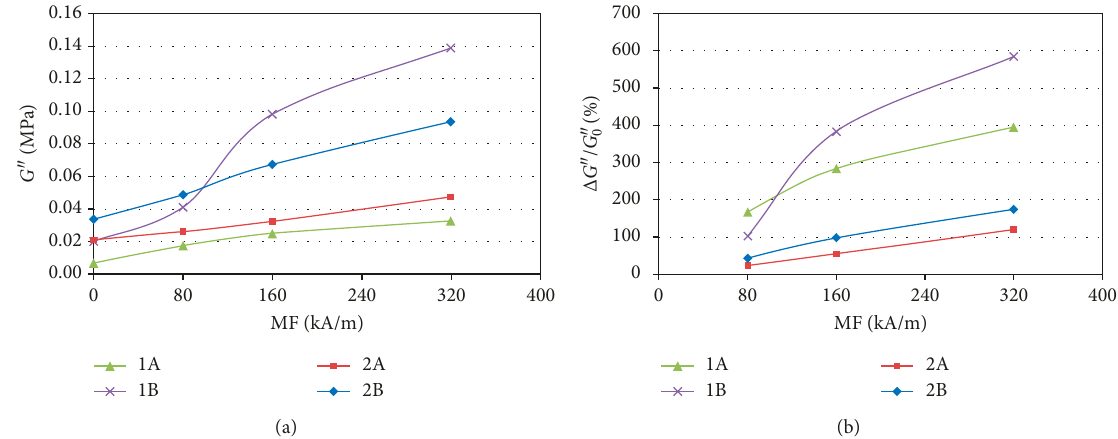
Figure 3: Loss modulus G and relative MR effect for samples under different magnetic field strengths. ″